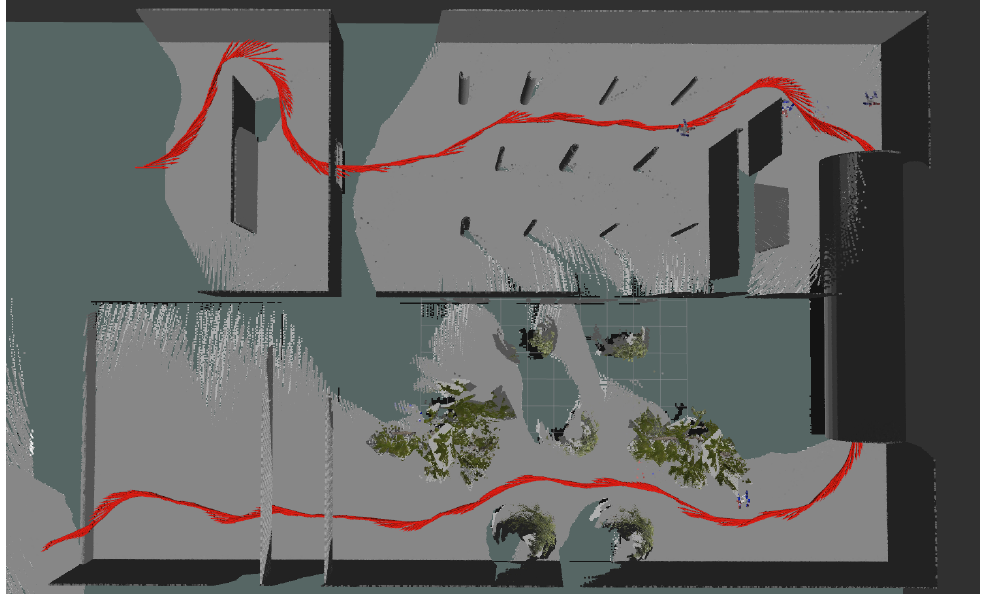
Figure 24. Visualization of the trajectory of UAV controlled by the SCAN algorithm (Area 1, Area 2, and Area 3) in rviz, top view.